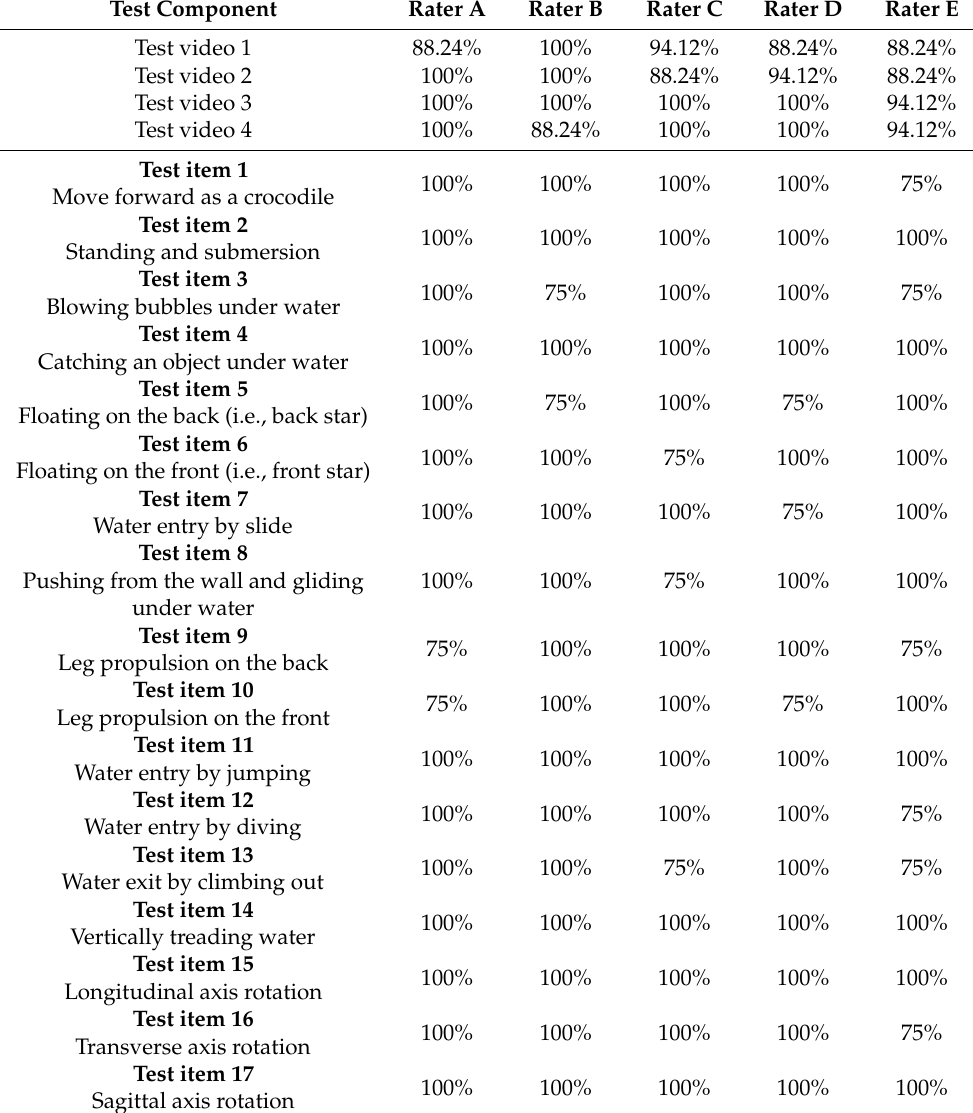
Table 7. Test re-test agreement per